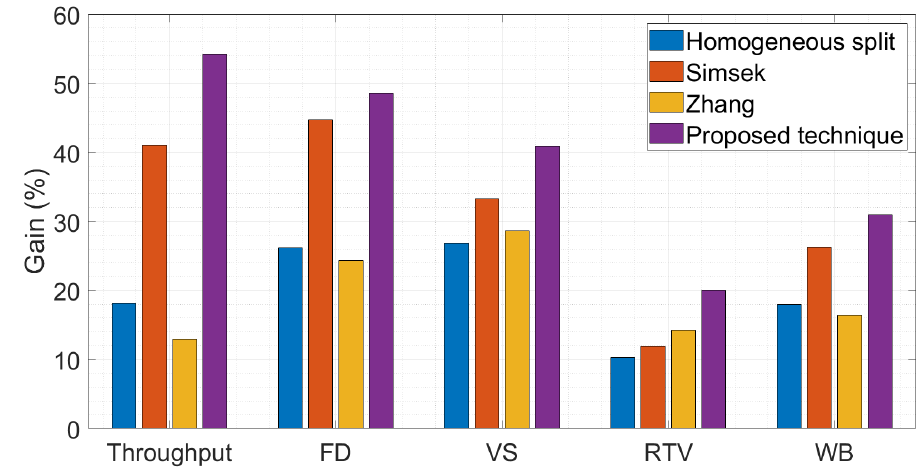
Figure 5. Relative gain of the UE download throughput and MOS achieved by each introduced technique with respect to the single-connectivity